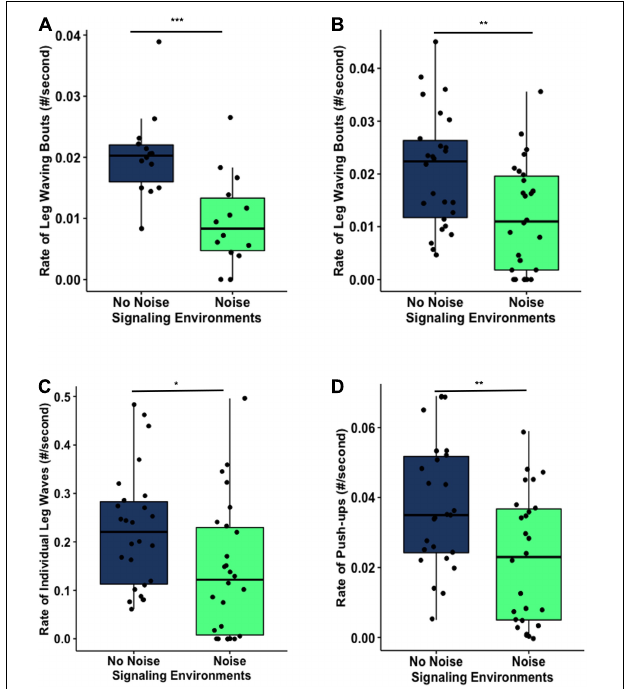
FIGURE 3 | Male courtship behavior is environment dependent. The rate of leg waving bouts by the males in the No Noise environment was significantly higher than that in the Noise environment in Experiment 1 ( A , *** p < 0.001) and in Experiment 2 ( B , ** p < 0.01). The rate of individual leg waves (C , * p < 0.05 ) and rate of push-ups (D , ** p < 0.01 ) in Experiment 2 were also significantly higher in the No Noise environment than in the Noise